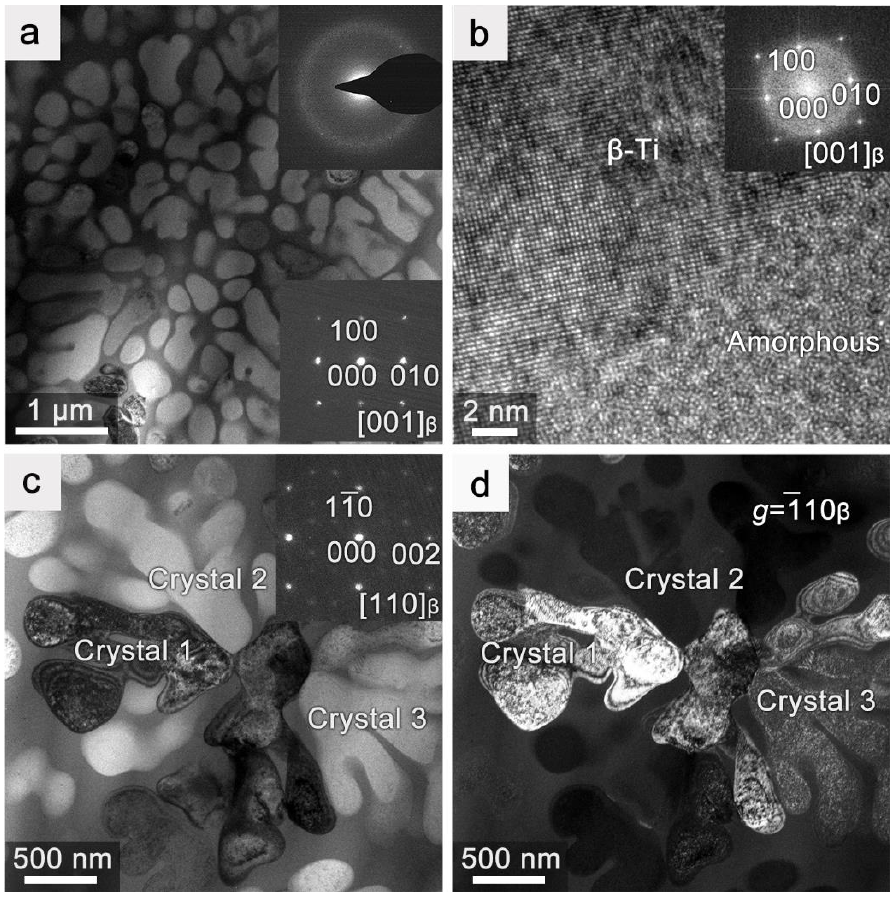
Figure 6. ( a ) TEM micrographs of the ZT-M strip with insets of SAED patterns from the glassy matrix (top) and from β -Ti (bottom). ( b ) HRTEM image taken from the glass / β -Ti interfacial region with the FFT pattern (inset). ( c ) and ( d ) are the bright-field and dark-field TEM micrographs, respectively, of a dendrite in the ZT-M strip.